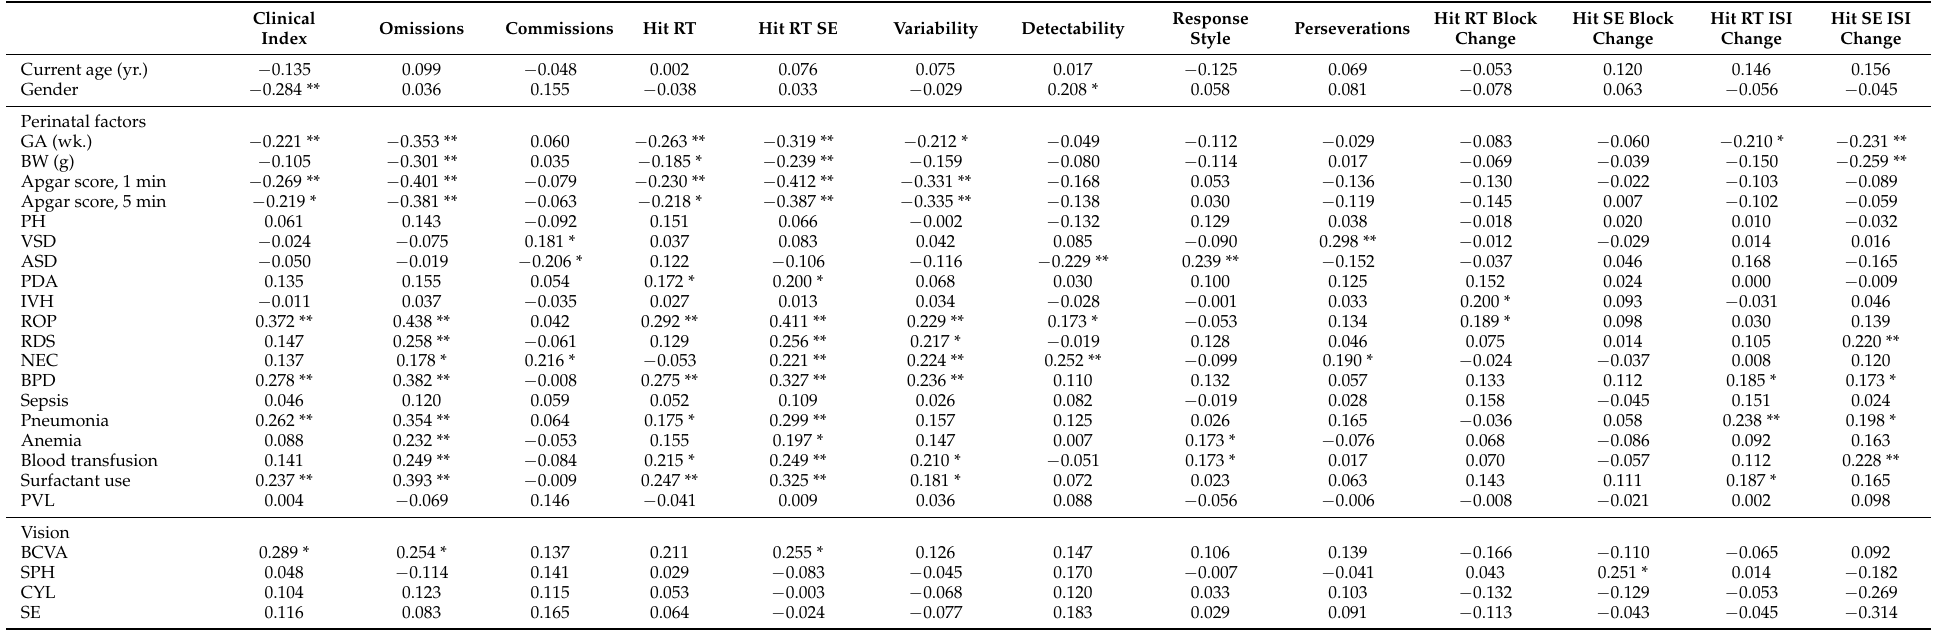
Table 4. The correlations between K-CPT variables demographic data, clinical data, and